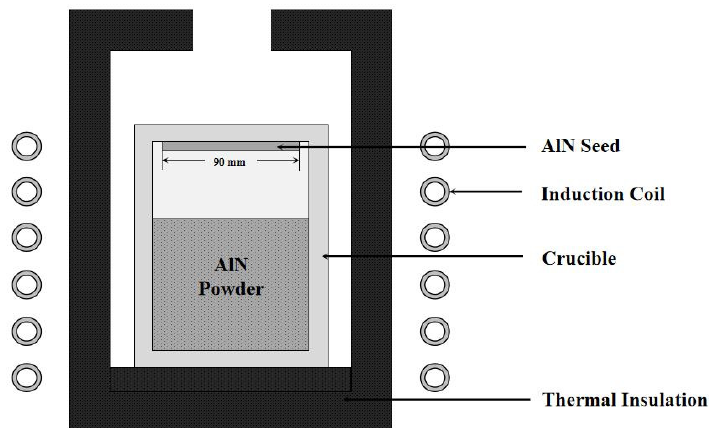
Figure 1. A sketch of the growth cell of AlN crystal.